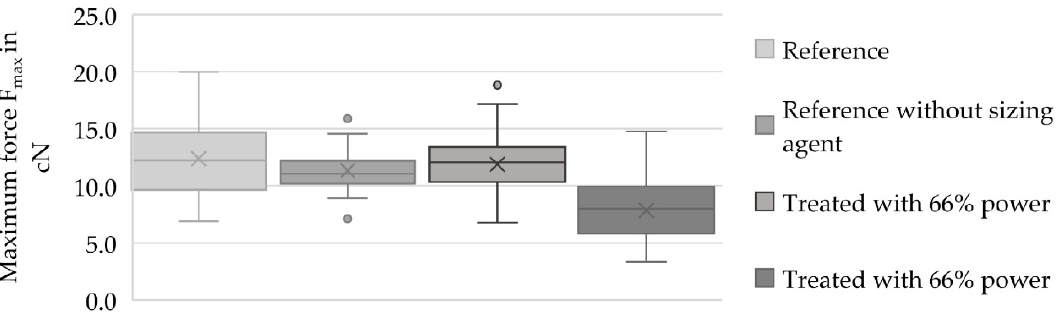
Figure 7. Boxplot diagram with the maximum elongation results (E max in %) of the filament references and the treated and detached filaments.